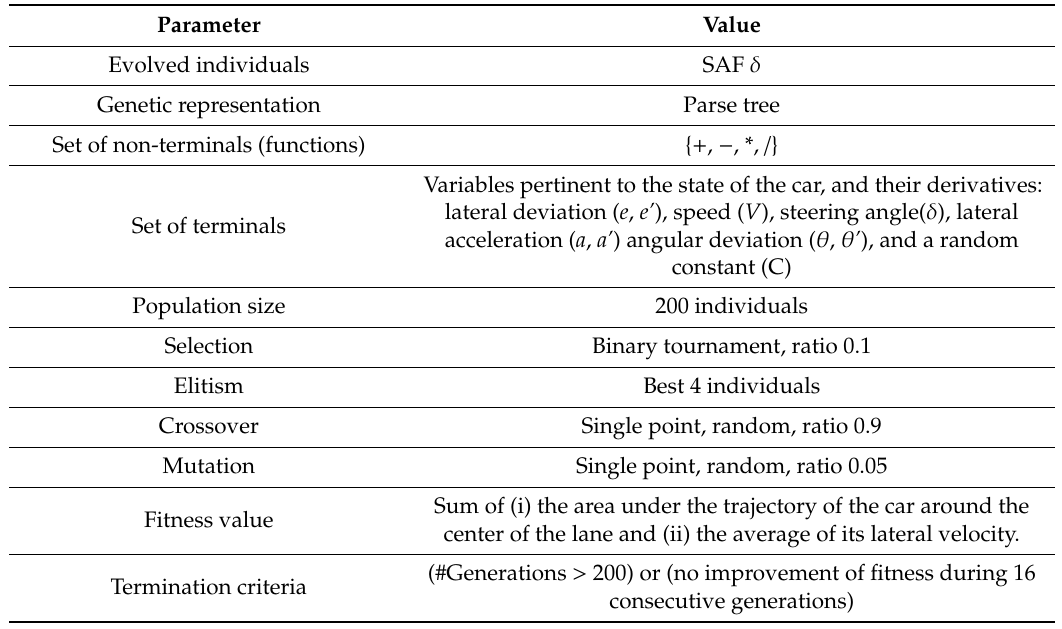
Table 3. Parameters of genetic programming